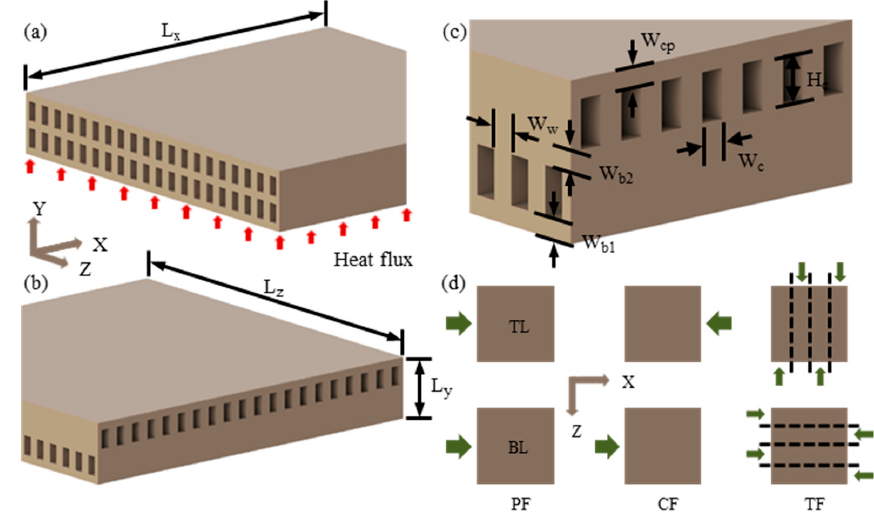
Figure 1. Schematic diagrams: ( a ) parallel-channel design (PF and CF); ( b ) cross-channel design (TF); ( c ) geometric parameters; and ( d ) flow conditions for top layer (TL) and bottom layer (BL).